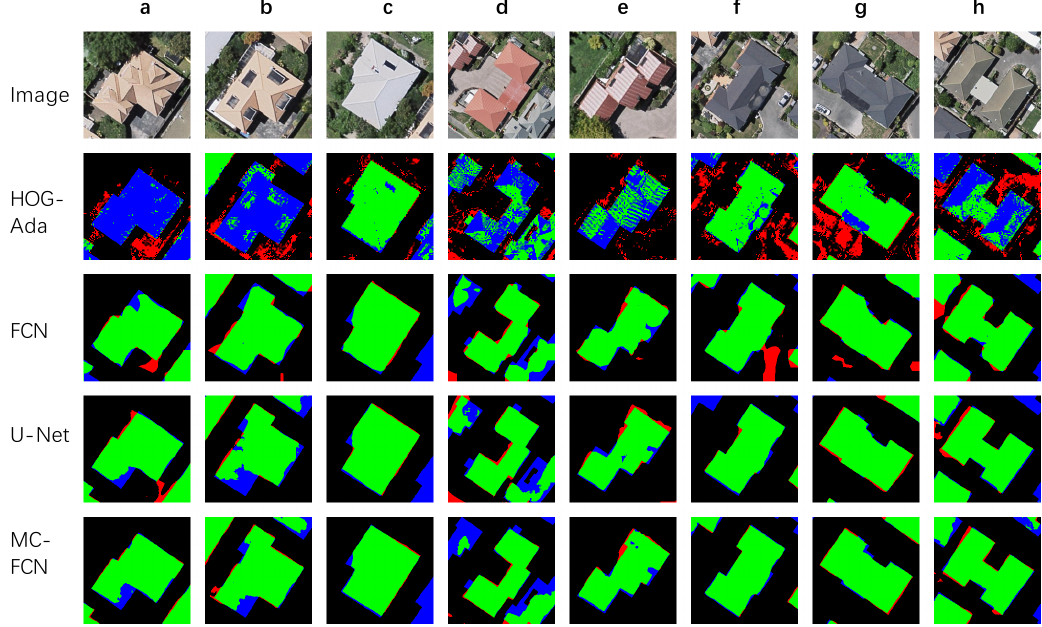
Figure 6. Segmentation results of randomly sampled buildings from the HOG–Ada, FCN, U–Net and MC–FCN methods. Images within columns ( a – h ) are sampled buildings from Test-1, Test-2 and Test-3 regions. The green, red and blue channels of results represent true positive, false positive and false negative predictions, respectively, of every